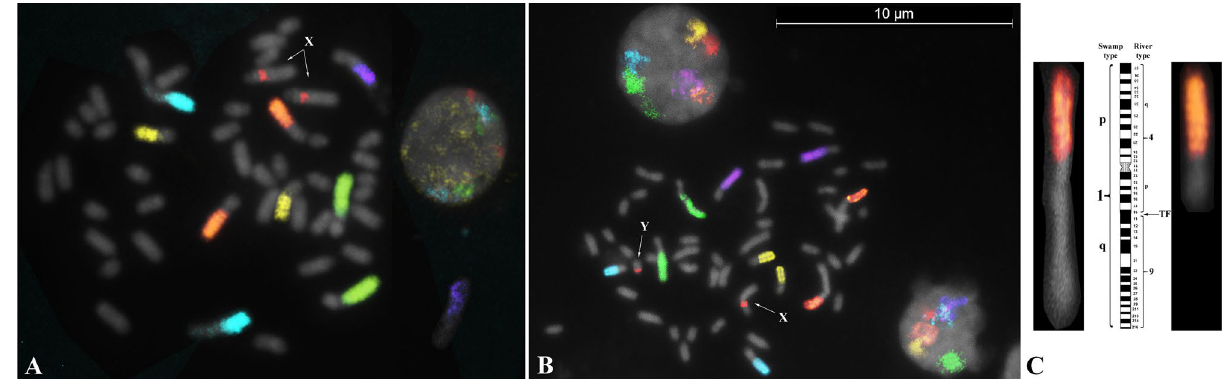
Figure 1. Multicolour hybridization with 6 DNA probes on normal buffalo metaphase spreads, ( A ) river type ( Bubalus bubalis , 2n = 50,XX); ( B ) swamp type ( Bubalus bubalis , 2n = 48,XY). The X probes showed a signal also on the Y-chromosome; ( C ) details on straightened swamp chromosome 1 (left) generated by the tandem fusion (TF) of the chromosomes 4 (right, upside down) and 9 of the river type. In the middle the R-banded ideogram of the chromosome.